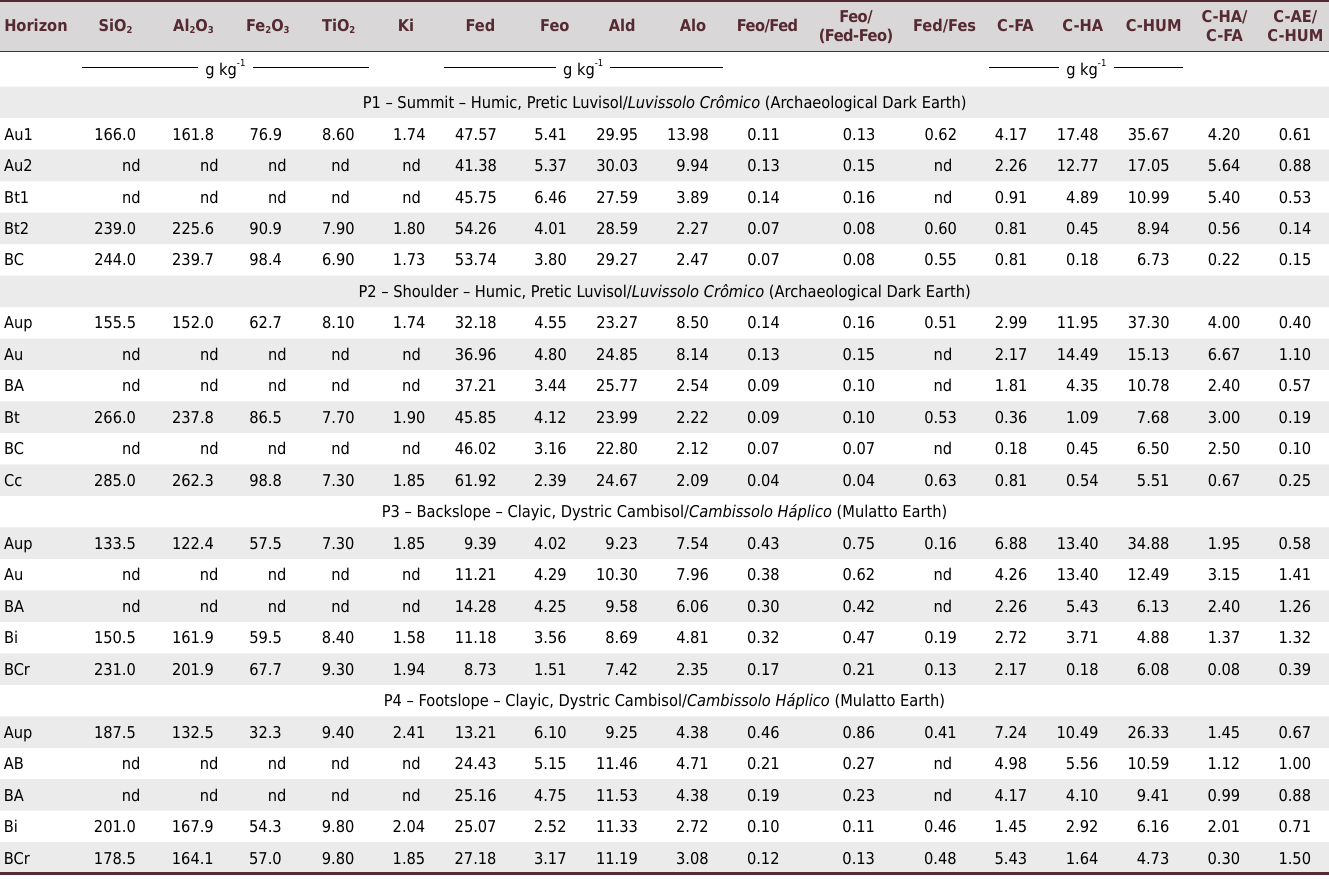
Table 4. Extractions of silicon, iron, aluminum, titanium, and fractions of the NaOH-extractable organic matter of Archaeological Dark Earth and Mulatto Earth in western Amazonia, Brazil Horizon SiO 2 Al 2 O 3 Fe 2 O 3 TiO 2 Ki Fed Feo Ald Alo Feo/Fed Feo/ (Fed-Feo) Fed/Fes C-FA g kg -1 P1 – Summit – Humic, Pretic Luvisol/ Luvissolo Crômico (Archaeological Dark Earth) Au1 166.0 161.8 Au2 nd nd nd nd nd Bt1 nd nd nd nd Bt2 239.0 225.6 90.9 BC 244.0 239.7 98.4 P2 – Shoulder – Humic, Pretic Luvisol/ Luvissolo Crômico (Archaeological Dark Earth) Aup 155.5 152.0 62.7 Au nd nd nd nd nd BA nd nd nd nd Bt 266.0 237.8